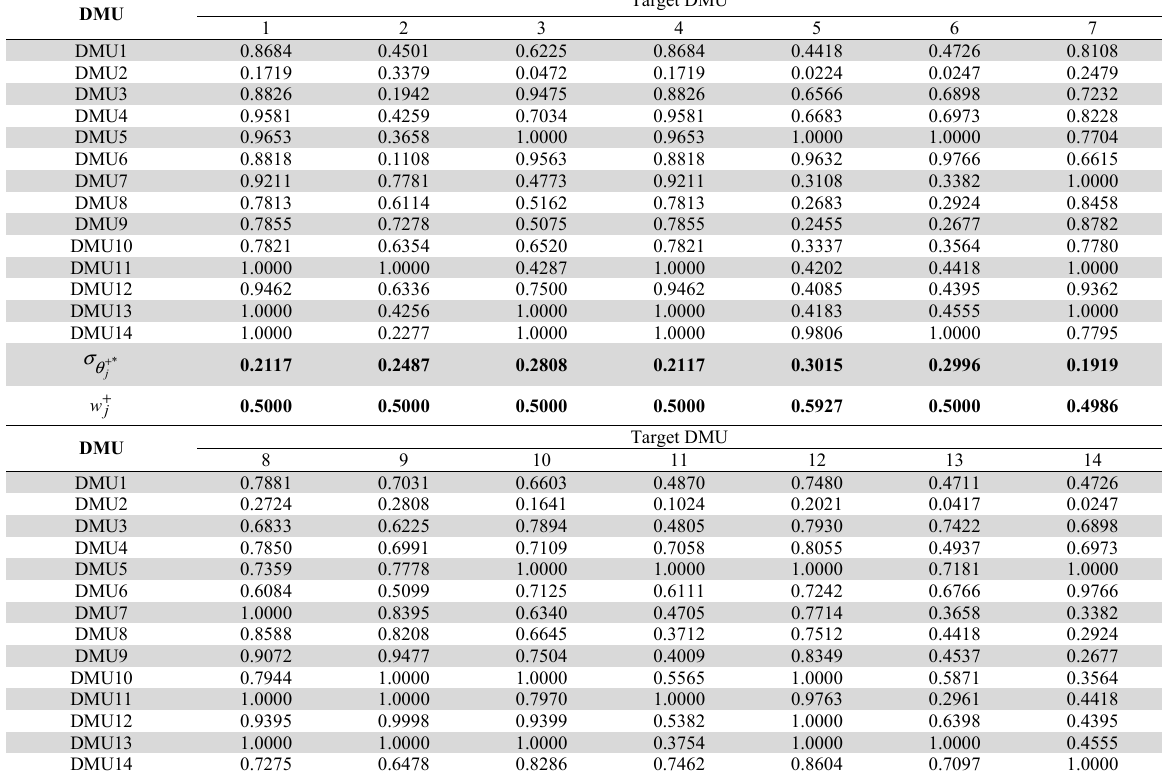
Consider a data set of fourteen international passenger airlines; each DMU has three inputs and two outputs as shown in Table 11. The efficiency scores based on the CCR model (Eq. (1)) must be evaluated first. After that, the Ideal model (Eq. (4)) and Anti-Ideal model (Eq. (5)) were coded using LINGO software. The results (using LINGO) of all models are shown in Appendix B. As a result, the Ideal CEM and Anti-Ideal CEM can be obtained as listed in Table 12 and Table 13 respectively. Ideal CEM of fourteen international passenger